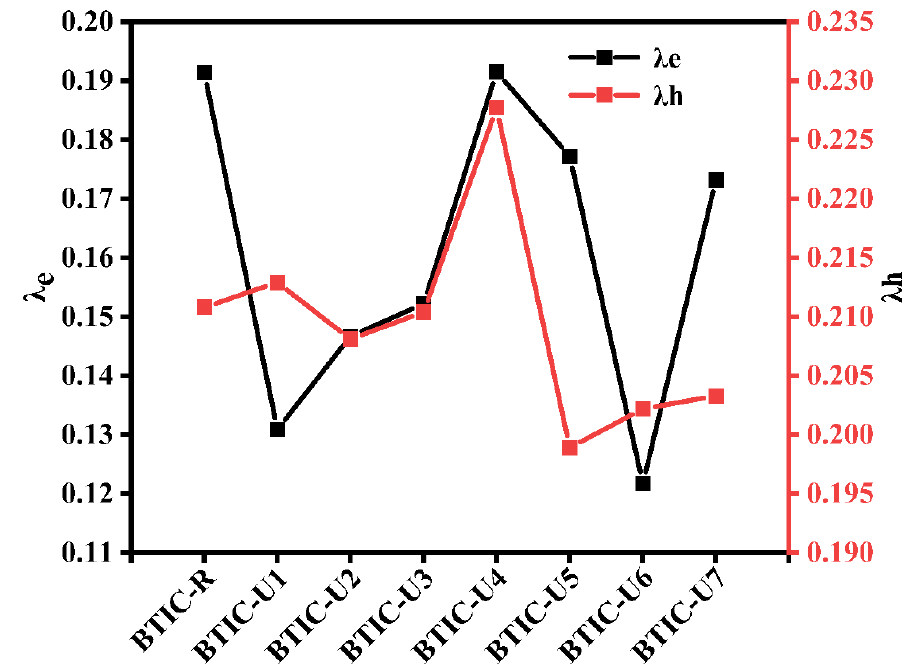
Figure 9. RE plot of λ e and λ h for BTIC − R and BTIC − U1 to BTIC − U7 molecules.